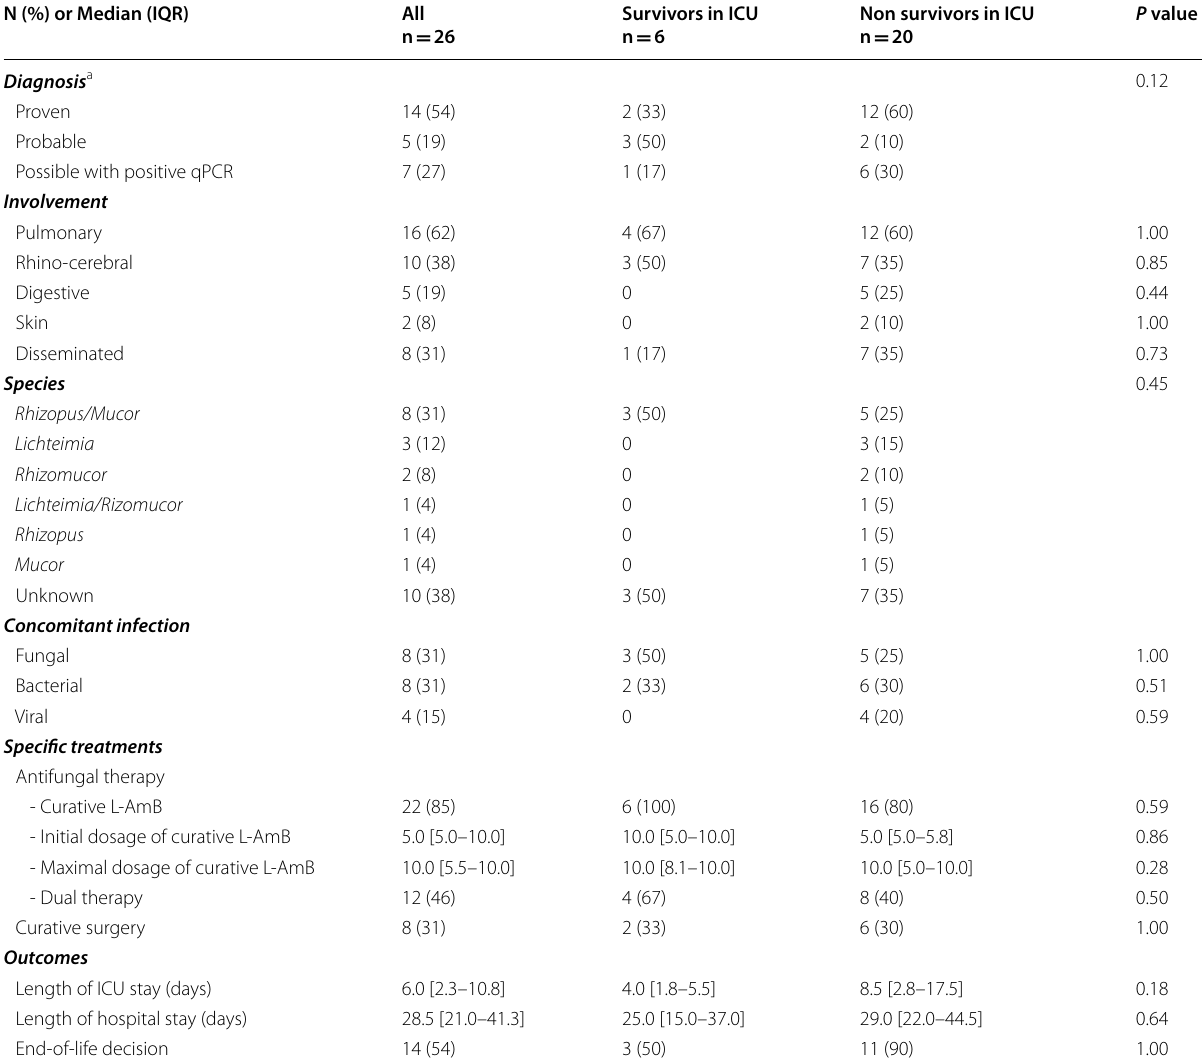
Table 2 Characteristics of mucormycosis and patients’